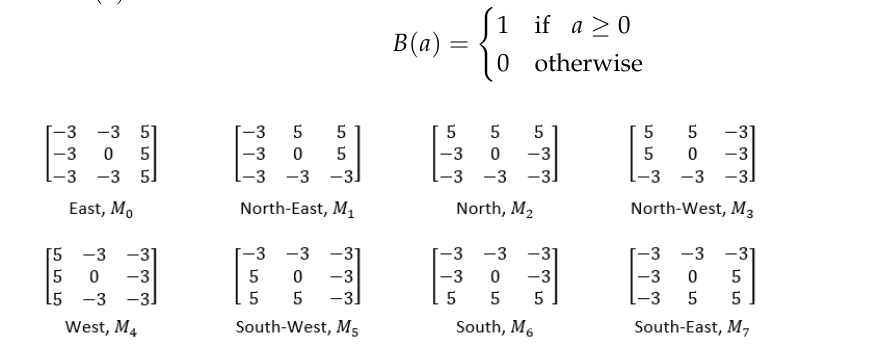
Figure 1. Kirsch edge